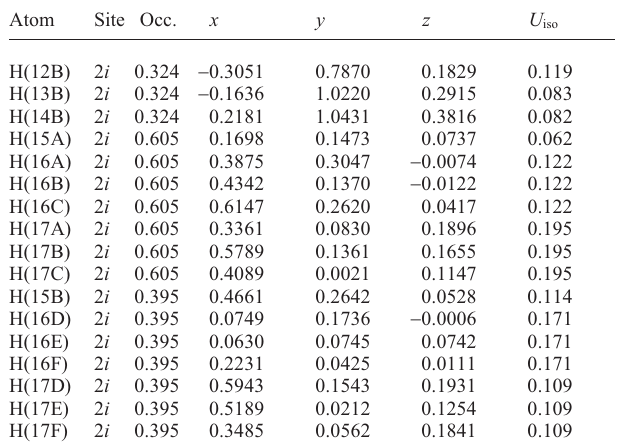
Table 3. Atomic coordinates and displacement parameters (in Å 2 )